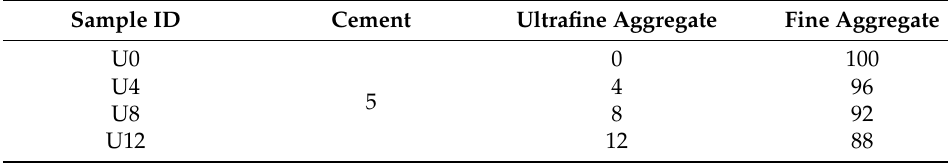
Table 1. Mix design of samples (wt. %).